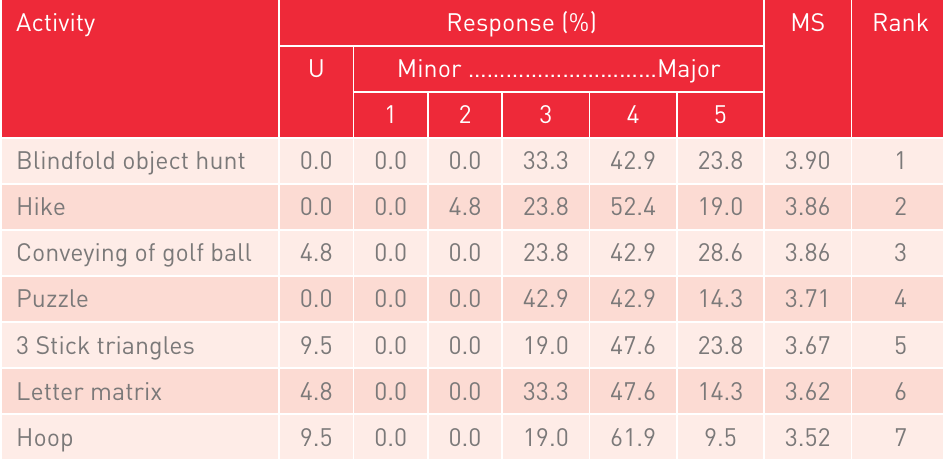
Extent to which the team building activities enhanced participants’ ability to strategize.